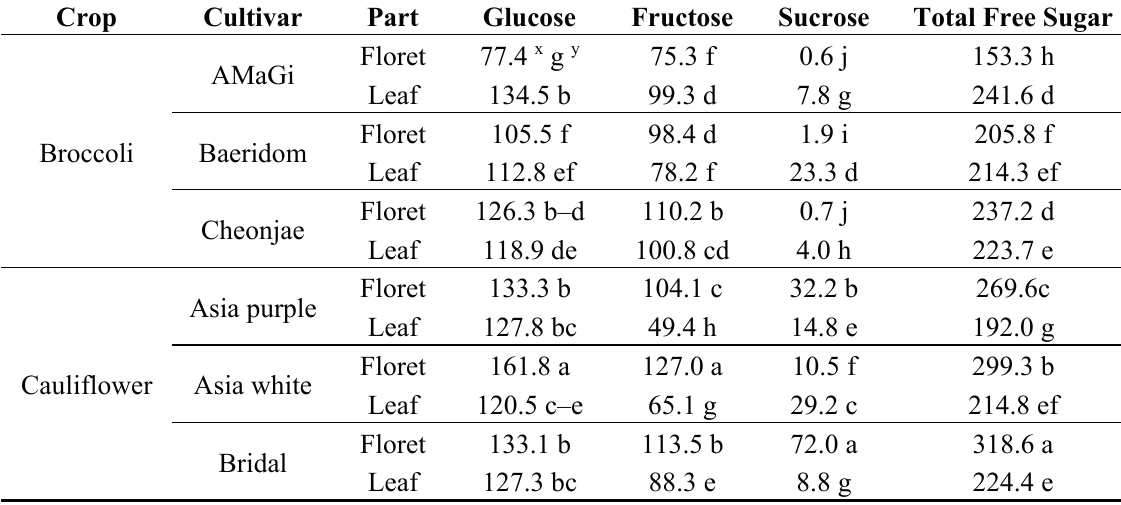
Table 2. Free sugar content (mg·g − 1 in dry weight) in various parts of broccoli and cauliflower